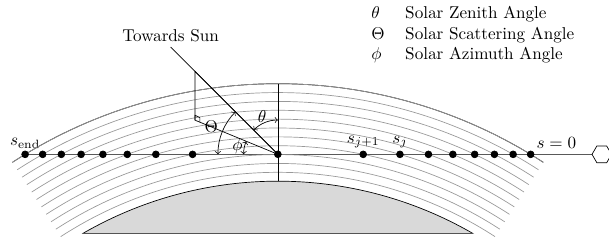
Figure 1. The limb-scatter geometry used in SO, HR, and MC. The solar viewing angles are defined at the tangent